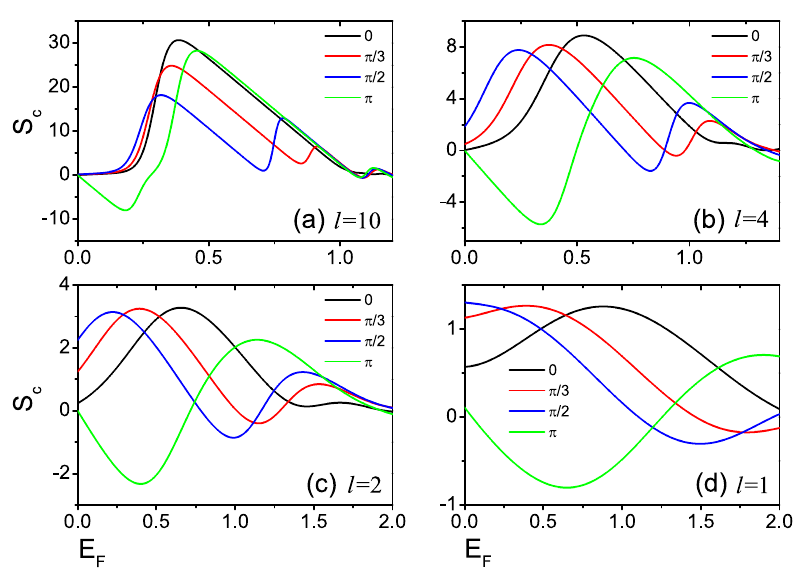
Figure 3. The Seebeck coefficients S c as functions of Fermi energy E F for several relative tilt φ with temperature T / T 0 = 0.02 in ( a ), and T / T 0 = 0.05 in ( b ), and T / T 0 = 0.1 in ( c ) and T / T 0 = 0.05 in ( d ). Two magnetic domains of equal size l = 10, 4, 2, 1. The temperatures are expressed in units of T 0 = ε